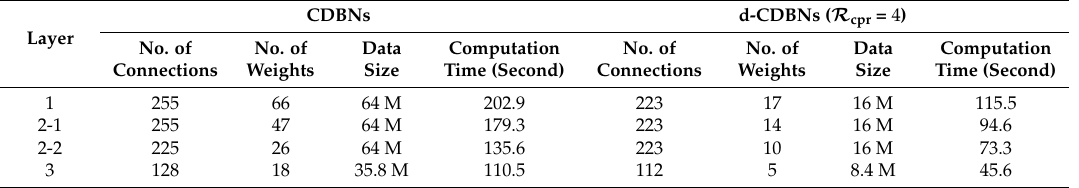
Table 9. Comparison of performance between CDBNs and d-CDBNs for city center scene.